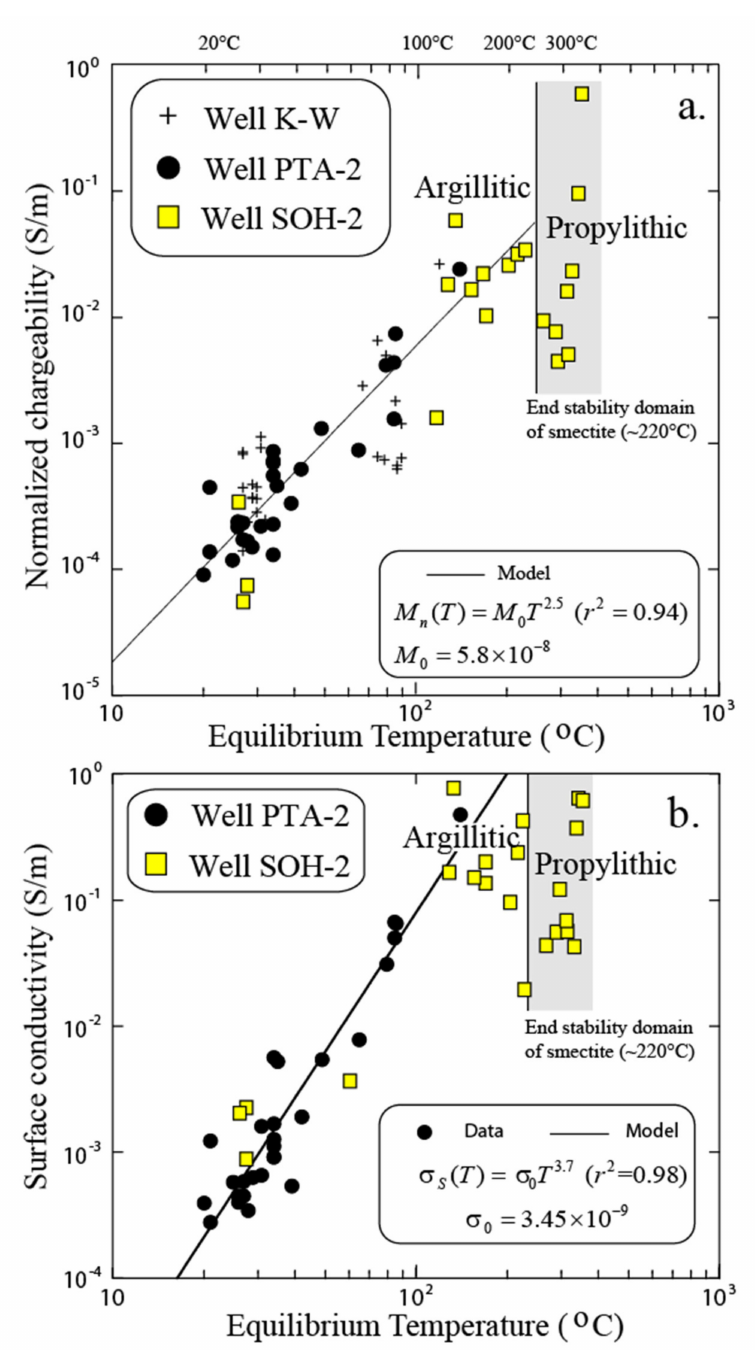
Figure 11. Field temperature dependence of the normalized chargeability and surface conductivity versus equilibrium temperature in the wells. ( a ) Relationship between the normalized chargeability (corrected for the in situ temperature) and the equilibrium temperature (with T in ◦ C) recorded in the wells. ( b ) Relationship between the surface conductivity (corrected for the in situ temperature) and the equilibrium temperature (with T in ◦ C) recorded in the boreholes. This dependence is much stronger than the dependence shown in Figure 7 and can be understood in terms of the variation of the CEC with the temperature-dependent mineralogy of the alteration facies described in Figure